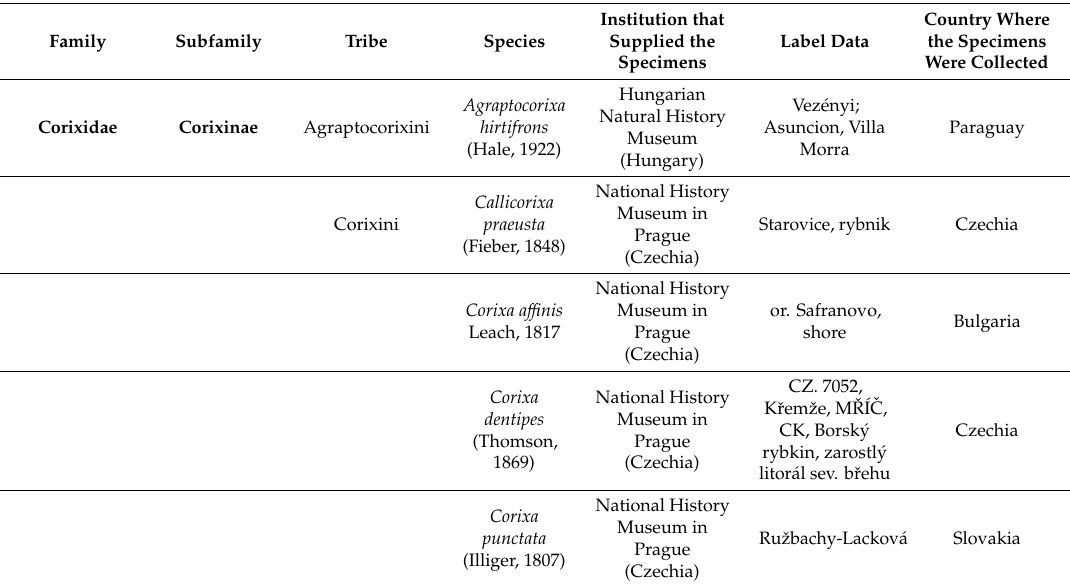
Table 1. Studied material of Corixidae and